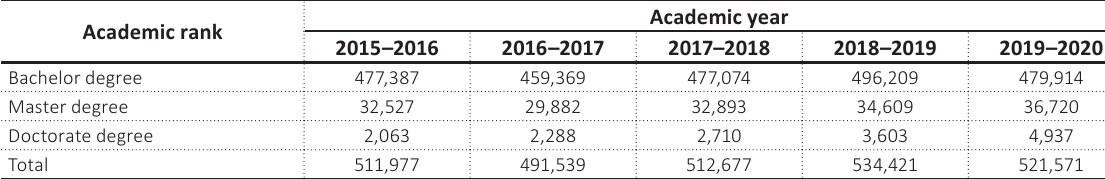
Table 1. Number of undergraduate and postgraduate students